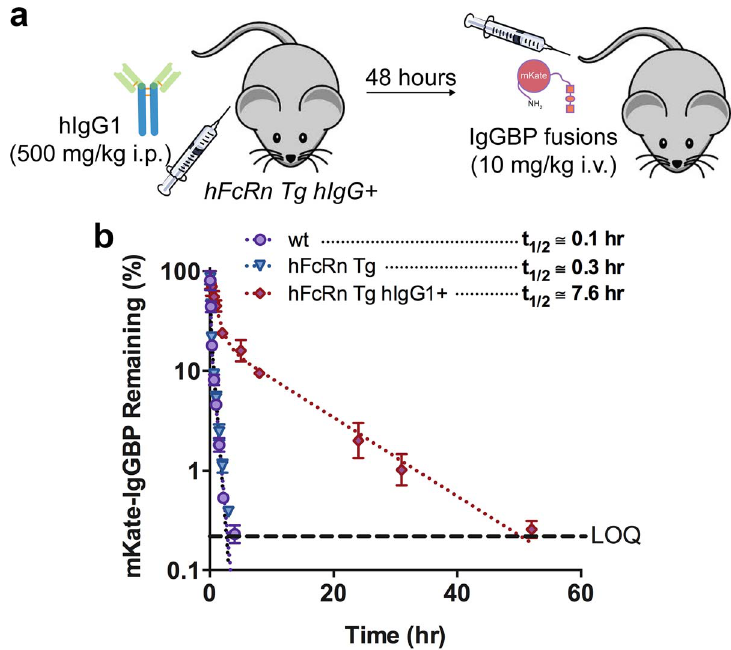
Figure 4. IgGBP fusion extends mKate half-life in hFcRn Tg hIgG + mice. ( a ) Schematic of the hFcRn Tg hIgG1 + mouse model. hFcRn Tg mice were dosed i.p. with 500 mg/kg of recombinant hIgG1 48 hours prior to injection of mKate-IgGBP. ( b ) Clearance of mKate-IgGBP in wild-type (purple circles), hFcRn Tg (blue triangle), and hFcRn Tg hIgG1 + (red diamond) mice dosed i.v. at 10 mg/kg via the tail vein as a single agent. The % mKate- IgGBP remaining was calculated by normalizing the fluorescent emission at all time points to the maximum value observed in the first bleed 5 min after protein injection. Dashed lines represent the data fit to a 2-compartment PK model in Prism and the b -phase half-life shown in the figure was calculated as described in the Methods section. The data shown are the mean (n=3 bleeds per time point) and error bars indicate